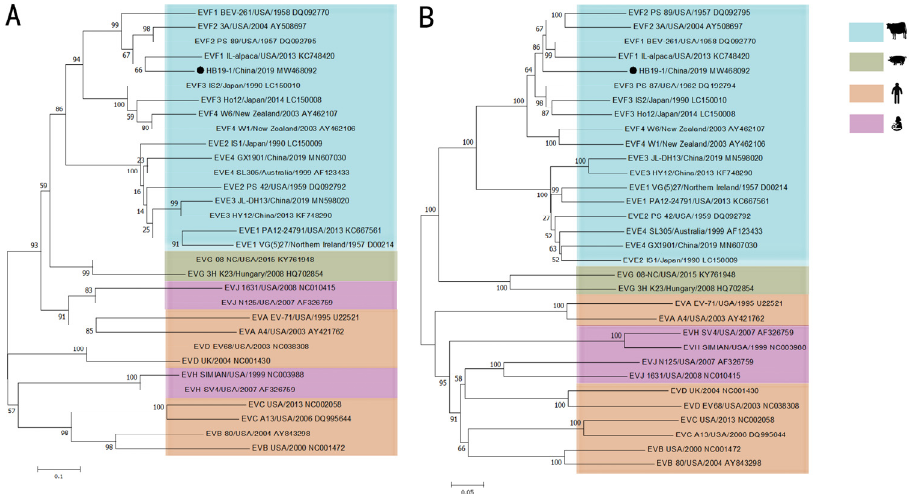
Figure 2. Phylogenetic analyses of the BEV HB19-1 strain. Phylogenetic analyses were based on the amino acid sequences. Phylogenetic trees were constructed using the neighbour-joining method with 1000 bootstrap replicates in the MEGA 7.0 software. The scale bars indicate the amino acid or nucleotide substitutions at each site: ( A ) VP1 of the BEV HB19-1 strain; ( B ) the polyprotein of the BEV HB19-1 strain.